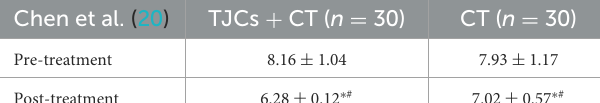
TABLE 3 HbA1c of TJCs + CT vs. CT